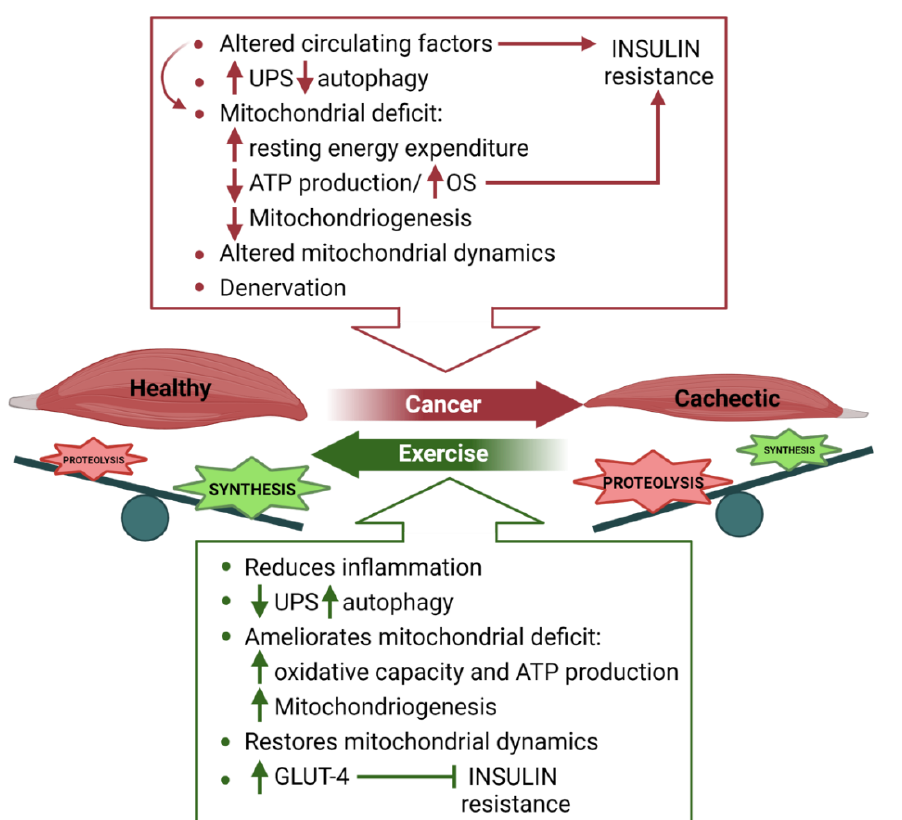
Figure 3. Metabolic reprogramming in cancer-induced cachexia and beneficial effects of exercise. In the red box are summarized the multiple pro-cachectic effects mediated by cancer. Impaired autophagy, energy expenditure, and denervation result in unbalanced protein homeostasis, overall leading to muscle wasting. In the green box are listed the anti-cachectic protective effects induced by exercise. Increased anti-inflammatory cytokines and suppression of the catabolic pathways lead to increased muscle mass and improved